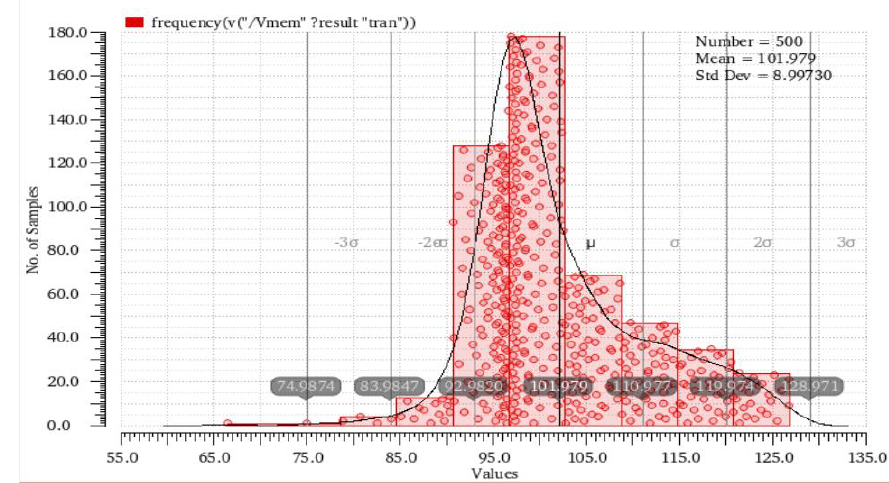
Figure 15. Monte Carlo analysis results.